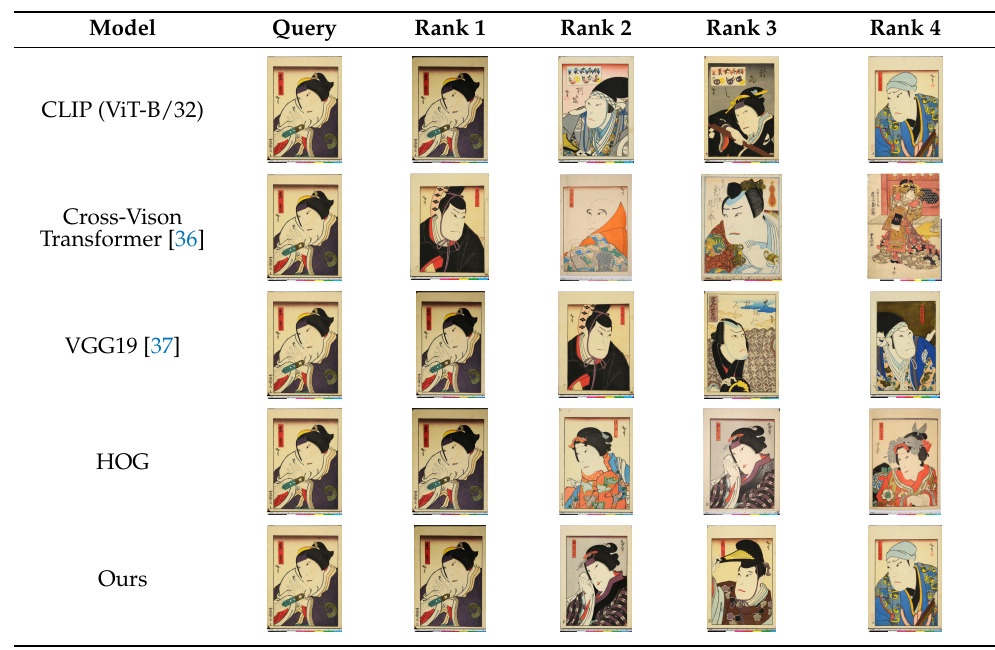
Table 12. Similar image retrieval using the ukiyo-e print digitized at the different institutions.